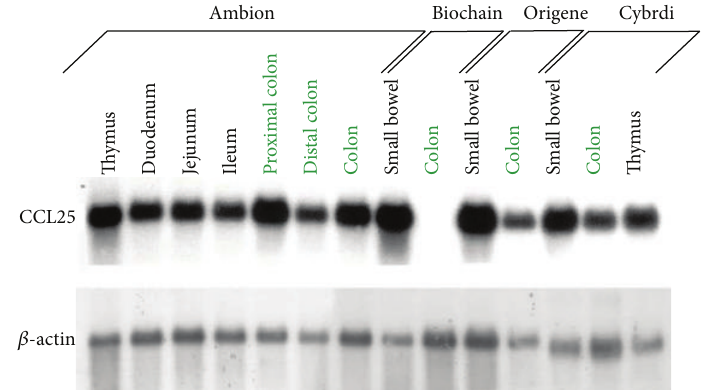
Figure 1: CCL25 mRNA is expressed in normal human colon. Normal intestinal mRNA samples purchased from multiple vendors were evaluated for CCL25 mRNA content by Northern Blotting. CCL25 mRNA was detected in 6 of 6 small intestine samples and 5 of 6 healthy colon samples.